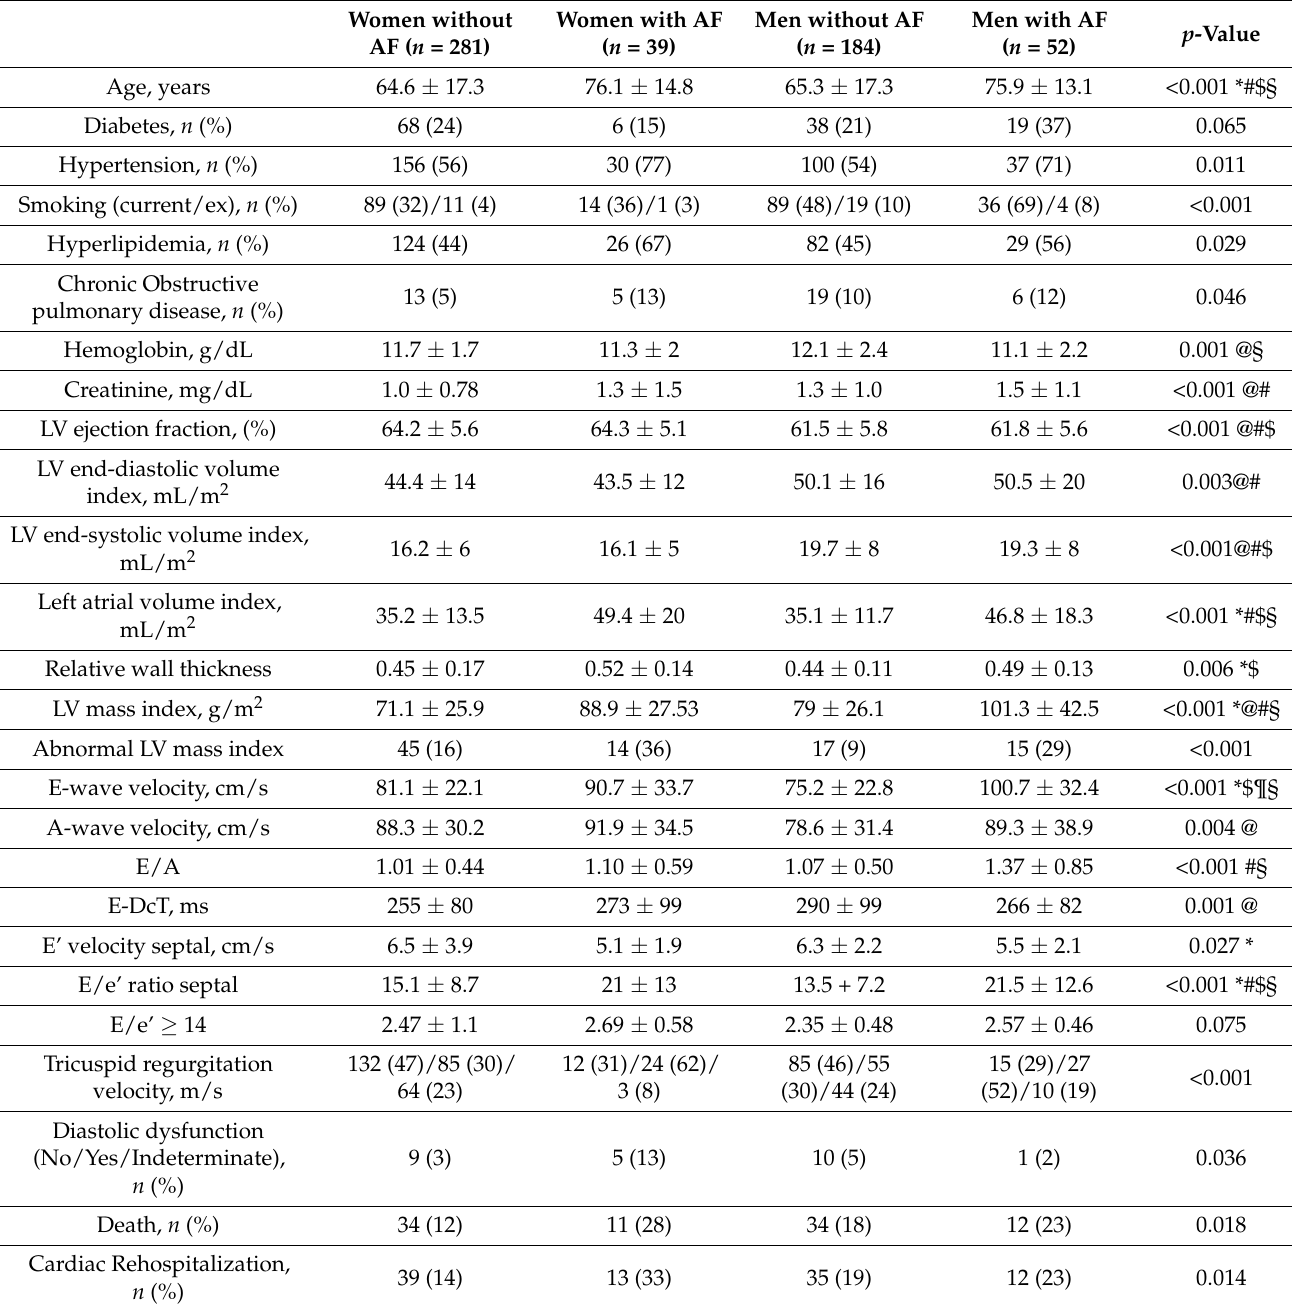
Table 2. Demographic, clinical and echocardiographic data in subgroups classified based on sex and presence of atrial fibrillation.